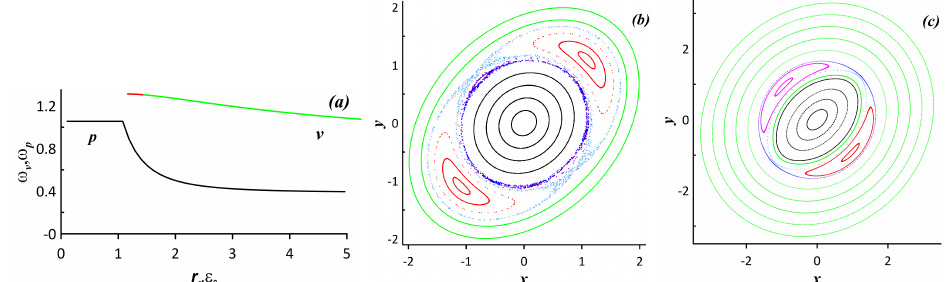
Figure 29. ( a ) Rotational frequencies of the corresponding stationary configurations: the numbers refer to the corresponding vortex motion regime; index p ( particle ) implies that the frequency curve corresponds to the stationary advection system, whereas v ( vortex ) stands for the corresponding vortex motion system. ( b , c ) Poincaré maps illustrating the appearance of chaotic motion regions in the advection system as the vortex oscillates or rotates: ( b ) e = 0.1, γ = 0.4, and the vortex oscillating from the initial position (cid:101) = 1.330625; and ( c ) e = 0.1, γ = 0.4, and the vortex rotating (cid:101) = 3.045.